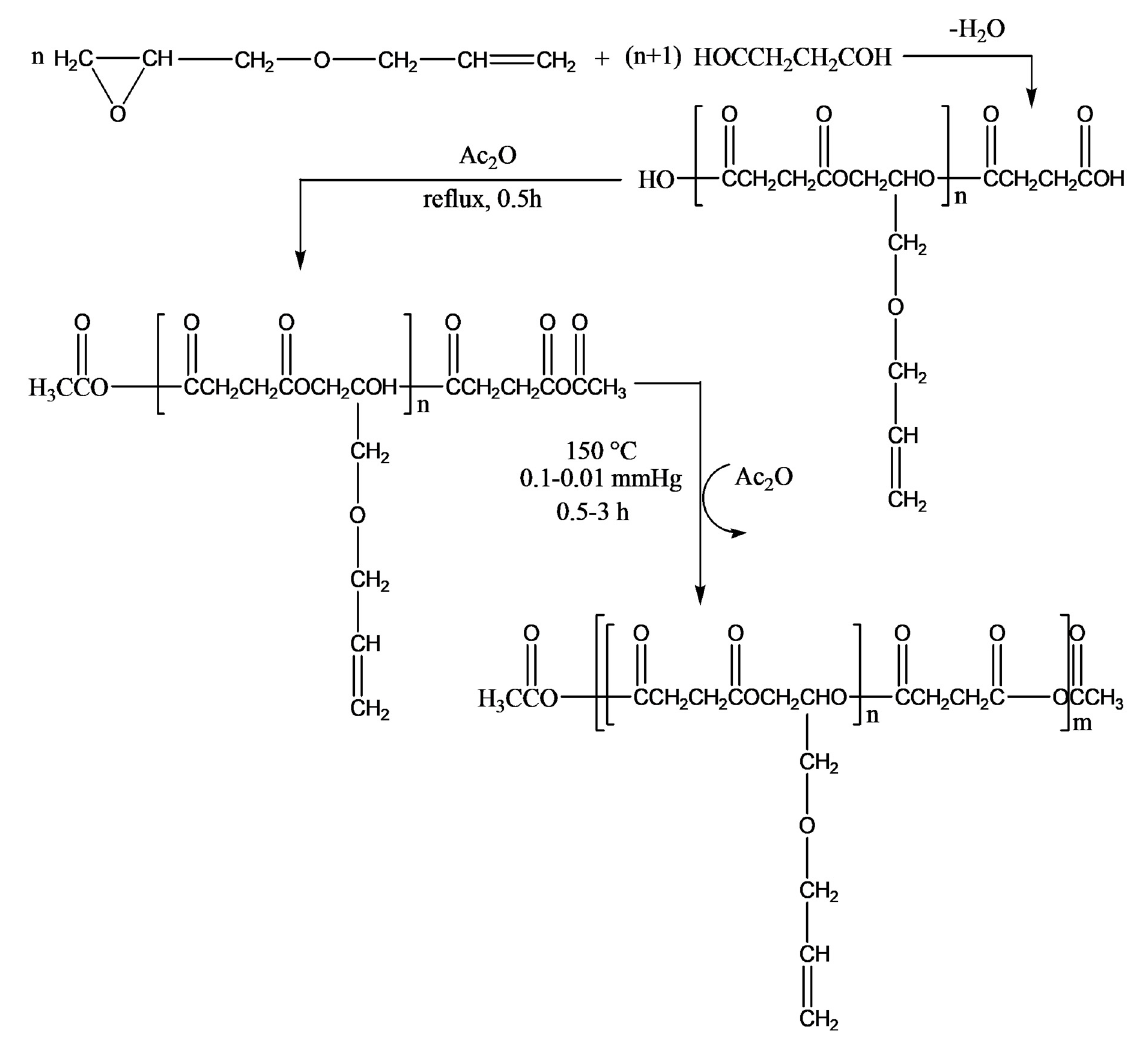
Figure 15. Polycondensation of succinic acid and allyl glycidyl ether, conversion of carboxyl end groups of the macromer to anhydride groups, and preparation of poly(ester-anhydride)s by melt polycondensation. Adapted with permission from [48]; published by Elsevier, 2008.